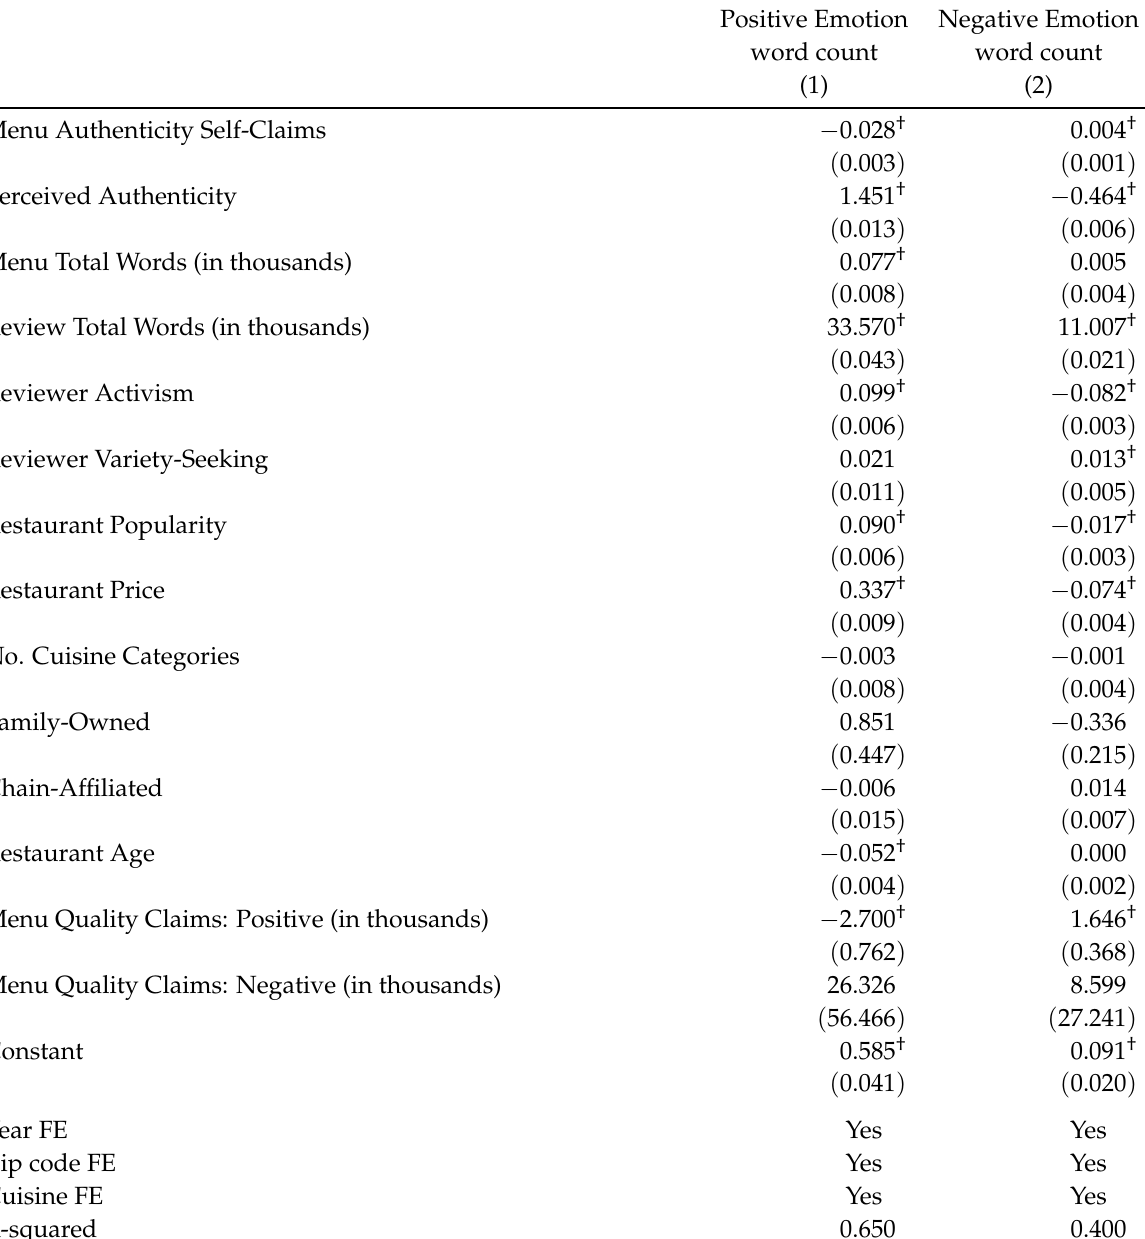
Table 3: OLS estimates of LIWC word scales using texts of online reviews (study